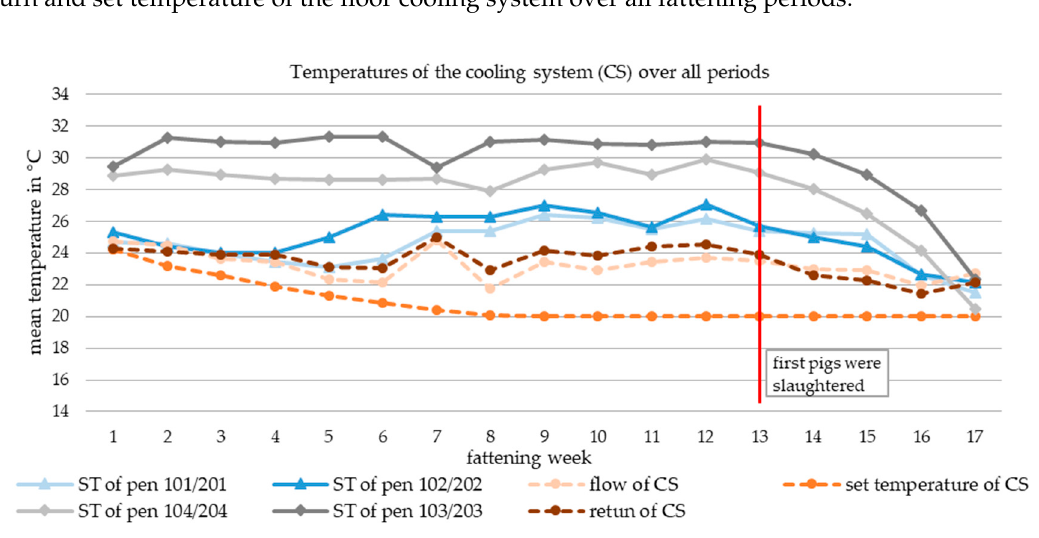
Figure 5. Average profile of all surface temperatures (ST) of the lying areas and the flow, return and set temperature of the floor cooling system (CS) over all fattening periods. The mean temperatures for each fattening week, which were formed from the records taken every minute by thirteen sensors over the three fattening periods, are shown. Each profile, except the set temperature of the floor cooling system, contains data of two sensors, one in each compartment.